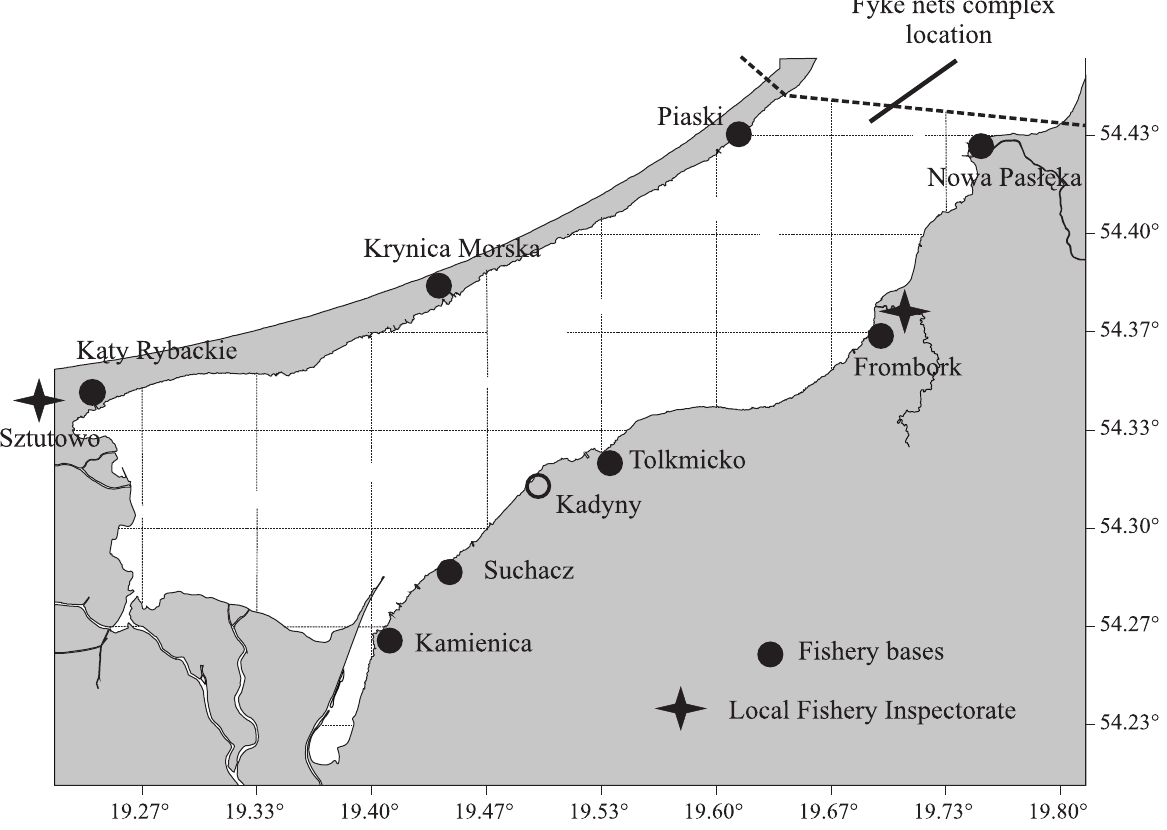
Fig. 1. Map of the studied area with network of squares used to monitor the fishing